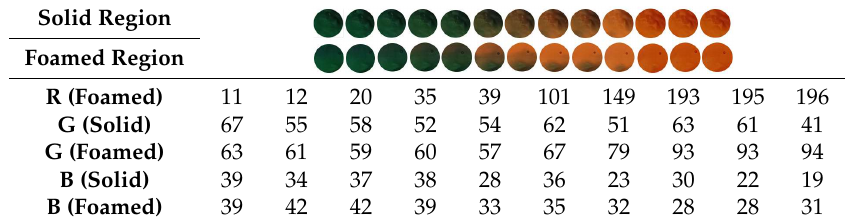
Figure 2. Detection process: Picture of the Hg(II) solution with the immersed films ( left ), and circular section selected from the picture of the film to obtain the RGB parameters ( right ). Table 1. RGB data from photographs taken from the solid and foamed regions of the sensory films after immersion for 60 min at RT in aqueous solutions (pH = 2.2, KCl–HCl) with a fixed concentration (913 ppm) of Hg(II).